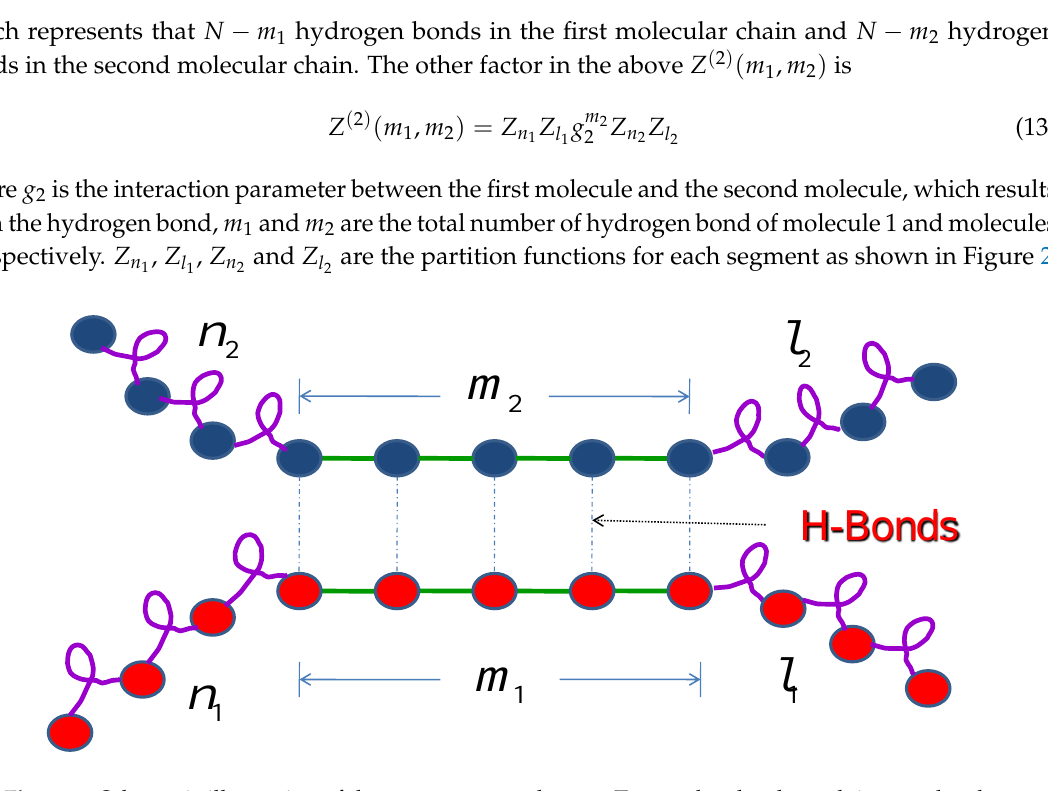
Figure 2. Schematic illustration of the monomer attachment. Two molecules through intermolecular hydrogen bond form a simplistic helix-coil-sheet model. m 1 and m 2 are the total number of hydrogen bonds for molecule 1 and molecule 2